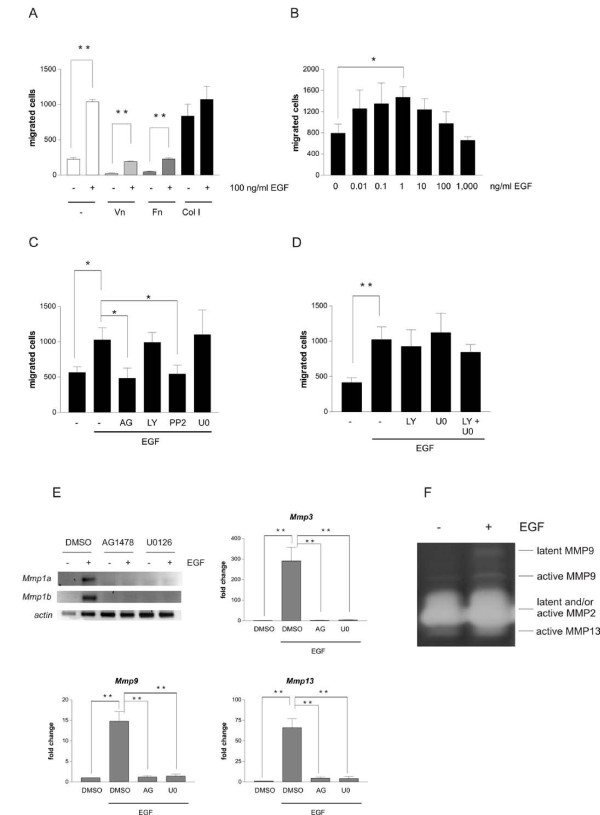
EGF induces melanocyte motility on collagen I and the expression of several matrix metalloproteases. A-D: Hm cells were serum-starved for 24 h and seeded onto the upper chamber of transwell migration inlays. The transwell migration assays were stopped after 12 h. Cells were stained with crystal violet and the number of transmigrated cells was counted. A: Hm cells were seeded onto uncoated transwell migration inlays or inlays previously coated with vitronectin (Vn), fibronectin (Fn) or collagen I (Col I). Where indicated, EGF were applied to the lower chamber. B: Transwell migration assay of Hm cells seeded onto collagen I-coated inlays. The indicated concentrations of EGF were applied to the lower chamber. C-D: Transwell migration assay of Hm cells seeded onto collagen I-coated inlays and stimulated with 1 ng/ml EGF, applied to the lower chamber. Cells were additionally treated with AG1478 (AG), LY294002 (LY), PP2, U0126 (U0) (C) or a combination of LY294002 and U0126 (LY + U0) (D). **: p < 0.001 (Student's t test, paired, two-tailed). E: Hm cells were serum-starved for 24 h and subsequently left untreated or treated with 100 ng/ml EGF in presence or absence of AG1478 or U0126. After 8 h, cells were harvested and reverse transcription-PCR (in case of Mmp1a and Mmp1b) or realtime-PCR analysis (in case of Mmp3, -9 and -13) were performed. Realtime-PCR data were normalized to expression of actin. **: p < 0.001 (Student's t test, paired, two-tailed). F: Zymographic analysis of the supernatant of starved or EGF-treated Hm cells after two days of stimulation.